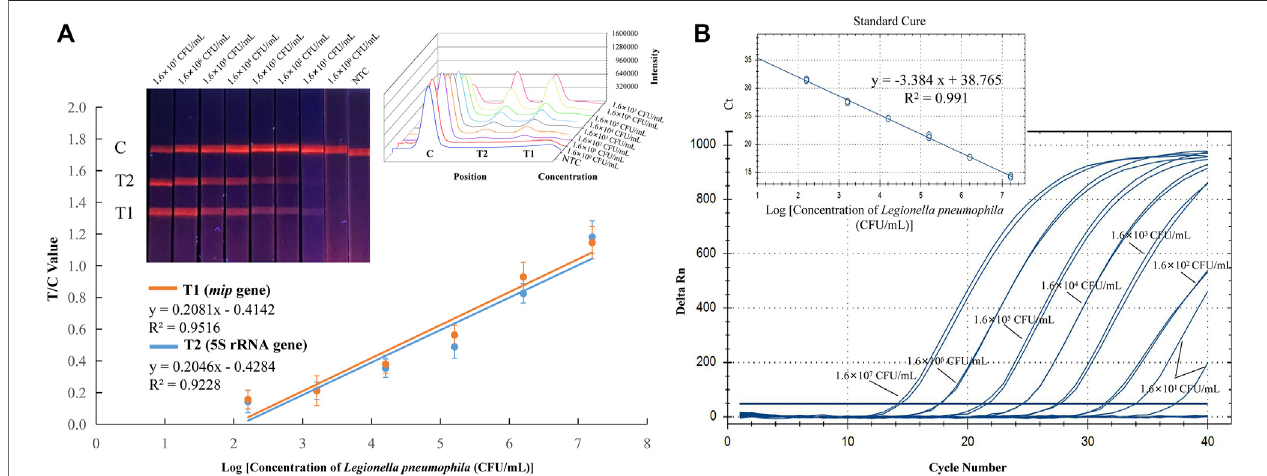
FIGURE 3 | Sensitivity of EuNPs-LFIC-RPA and qPCR assays for Legionella pneumophila . Sensitivity was evaluated with Legionella pneumophila strain ranging from 1.6×10 7 to1.6×10 0 CFU/ml. (A) Theampli fi edproductscouldbeobservedwithlateral fl owstrips under365 nm UVlamp. Theintensitywasusedforquantitative analysis(plotted byOrigin8), and itshowsalinearcorrelationwiththeconcentrationofpurecultures. (B) TheqPCR assayused thesame gradient concentrationofpure cultures, and the standard curve was generated with the Bio-Rad CFX Manager.